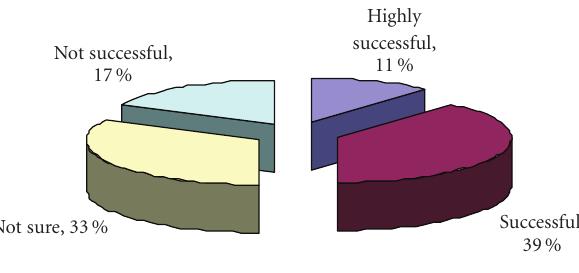
Figure 3: Success rating in using MFIX.